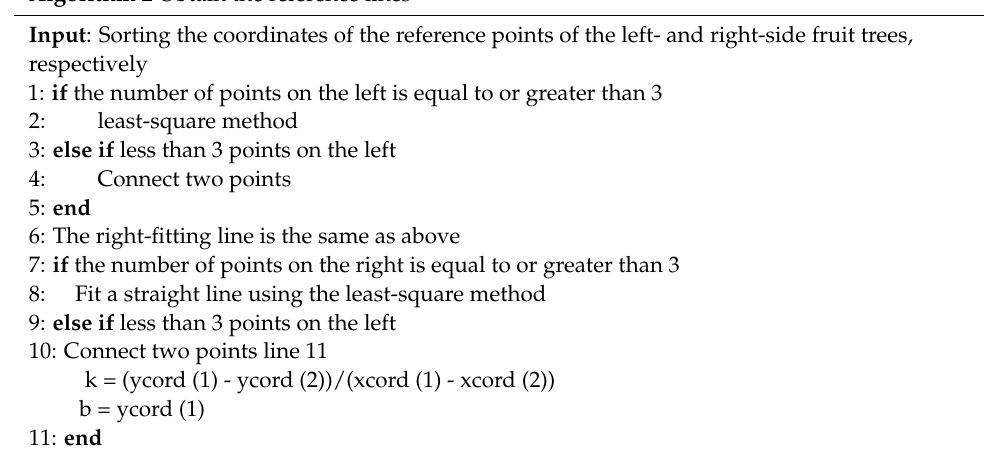
Algorithm 2 Obtain the reference